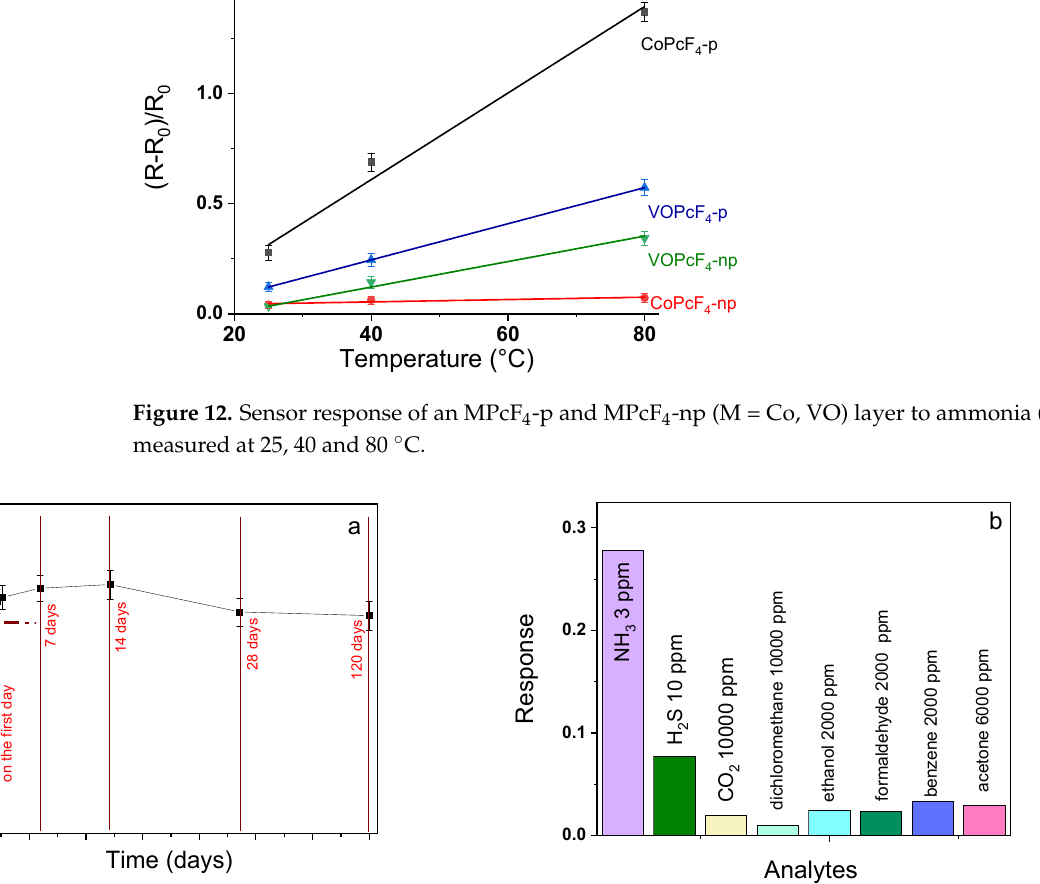
Figure 12. Sensor response of an MPcF 4 -p and MPcF 4 -np (M = Co, VO) layer to ammonia (3 ppm) measured at 25, 40 and 80 °C.